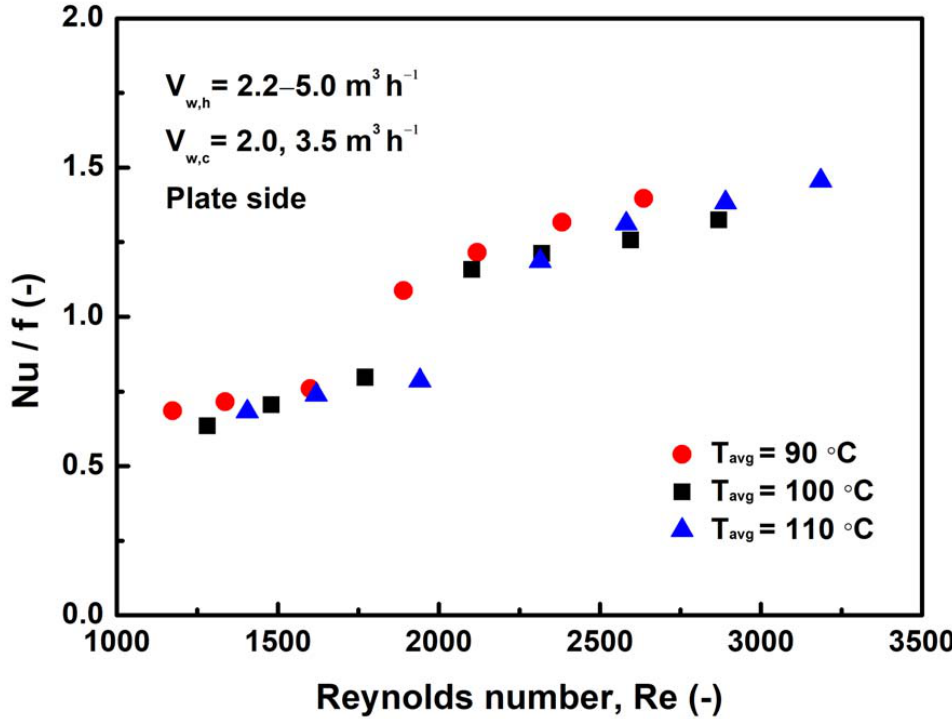
Figure 12. Variation in the Nu/ f with respect to the Re.